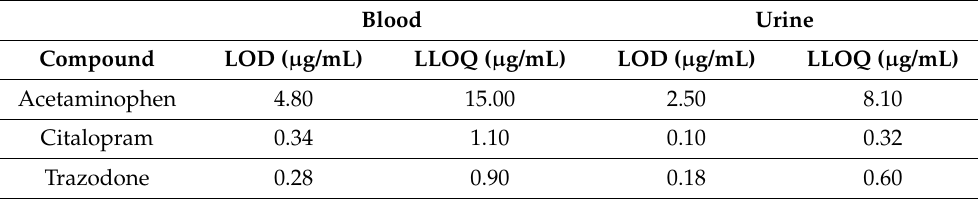
Table 1. LOD and LLOQ for acetaminophen, trazodone and citalopram in blood and urine. Blood